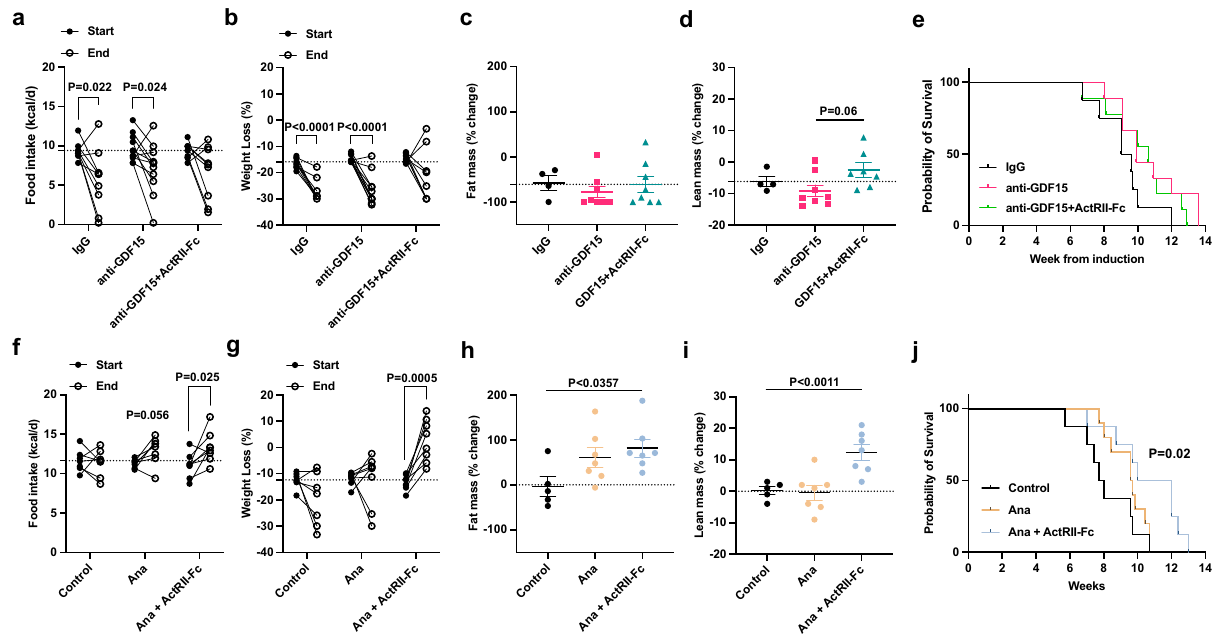
Fig. 5 | Anamorelin but not GDF15 in combination with ActRIIB-Fc improves bodyweight,activity,andoverallsurvivalinfemaleKLmicewithCACS.a Food intake(kcal/d)atweek0(Start)andafter2weeksoftreatment(End)withcontrol immunoglobulin(IgG, n =9), anti-GDF15 mAB( n =11) or ActRIIB-Fc decoy mAb in combination withGDF15mAb( n =9). b TotalbodyweightlossatStart andEndin mice treated with either IgG ( n =9), anti-GDF15 monoclonal antibody ( n =11) or anti-GDF15 mAbtogether withanActRIIB-Fc decoy mAb ( n =9).Percentageoffat mass ( c ) and lean mass ( d ) change after 2 weeks of treatment with either IgG ( n =4), anti-GDF15 monoclonal antibody ( n =8) or anti-GDF15 mAb together with a decoy ActRIIB-Fc mAb ( n =8). e Kaplan-Meier (KM) plot with the probability of survival of the mice from ( b ). f Food intake (kcal/d) at Start and End with control IgG ( n =7), anamorelin (Ana, n =7) or ActRIIB-Fc decoy mAb in combination with Ana ( n =8). g Total body weight loss at Start and End in mice treated with either